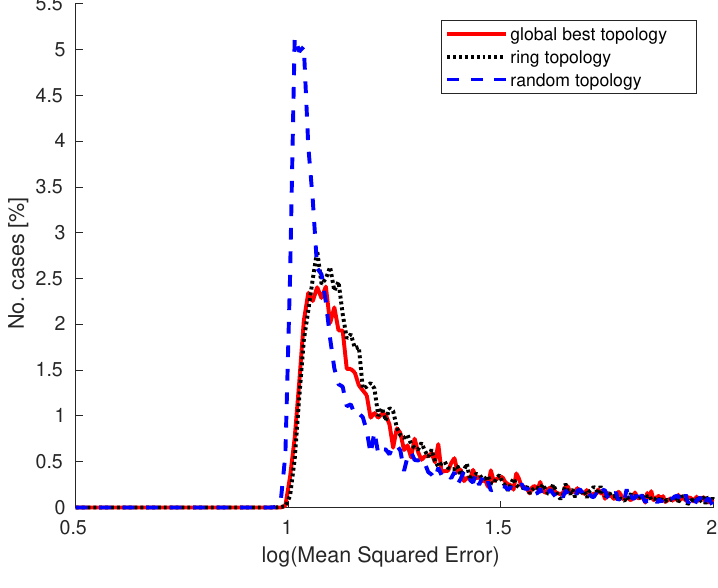
Figure 12. Histogram of